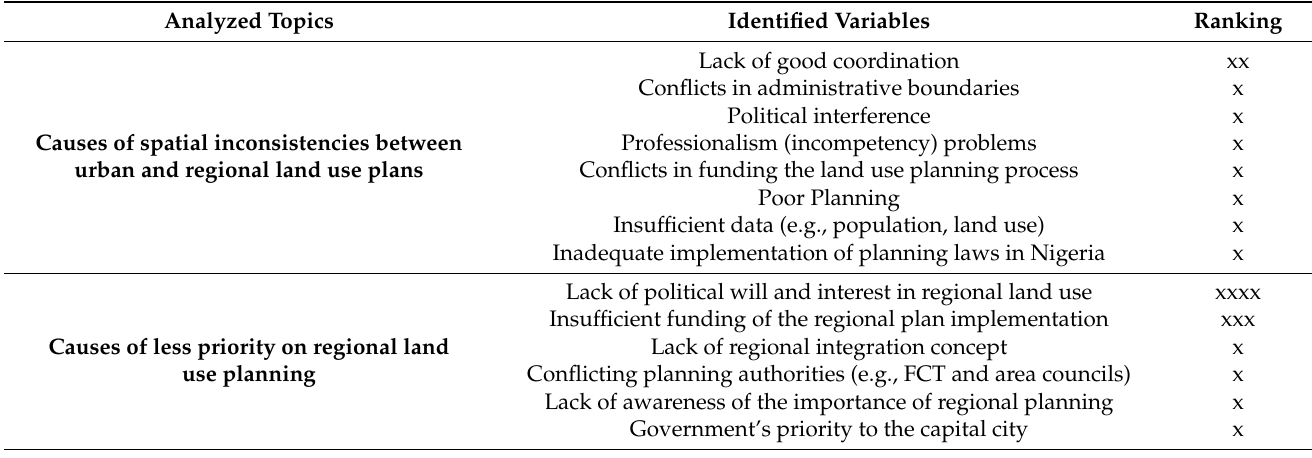
Table 4. Causes of spatial inconsistencies between urban and regional plans and less priority on regional land use planning based on a survey of experts.